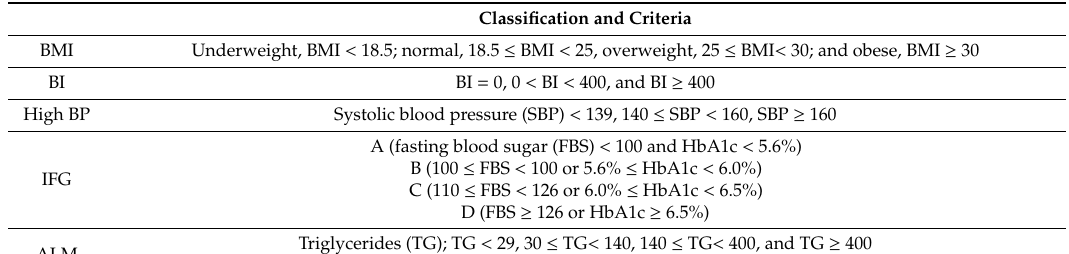
Table 2. Classification of body mass index (BMI), Brinkman index (BI), high blood pressure (BP), and criteria of impaired fasting glucose (IFG) and abnormal lipid metabolism